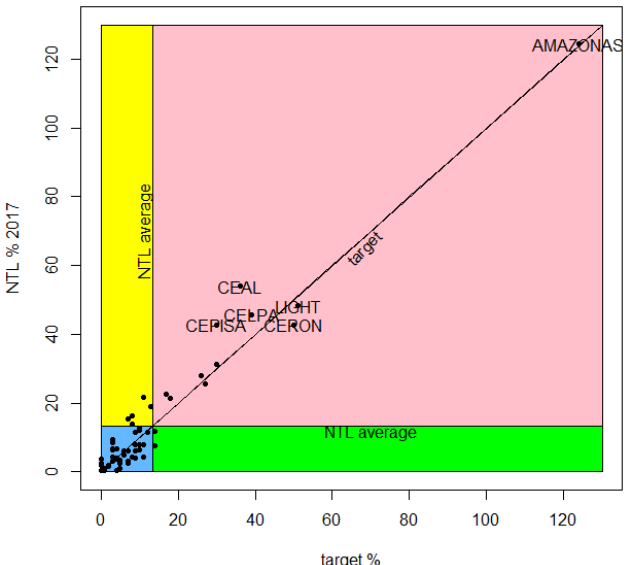
Figure 7. Scatterplot of the averages of the expected values estimated divided into four quadrants.